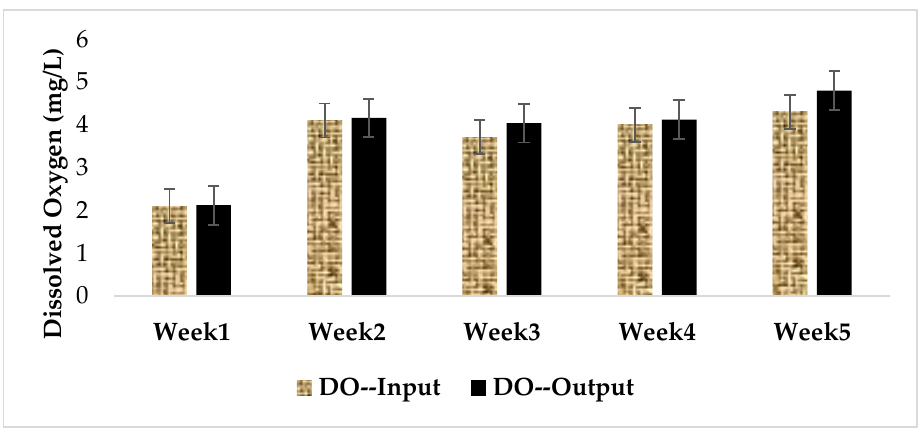
Figure 3. Dissolved oxygen (DO) of the influent and effluent during the experiment. The highest values of electrical conductivity were 135.67 ± 129.65 µs/Cm and 315.17 ± 87.49 µs/Cm at the inlet and outlet of the MSL pilot, respectively, and the lowest values were 17.69 ± 7.47 µ s/Cm and 215.17 ± 16.24 µ s/Cm at the inlet and outlet, respectively, of the MSL (Figure